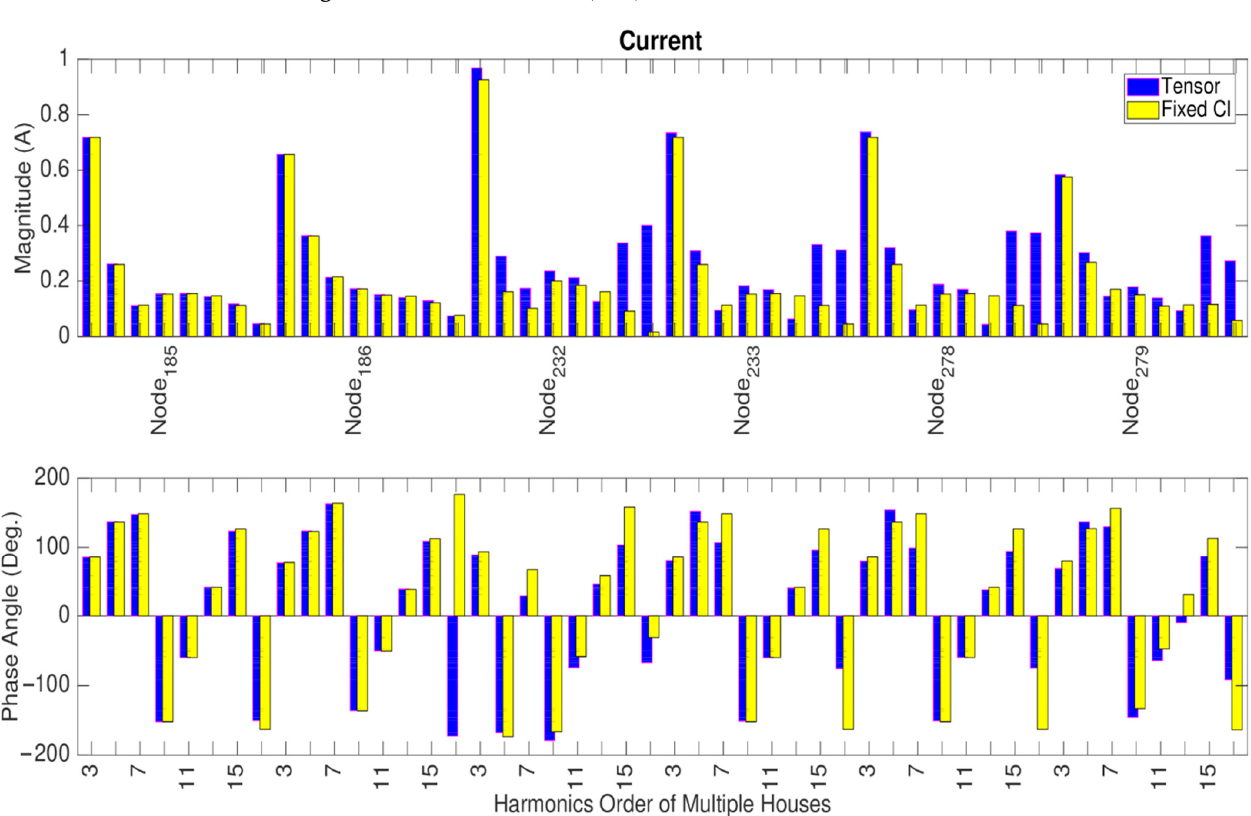
Figure 9. Urban LV network (60%).